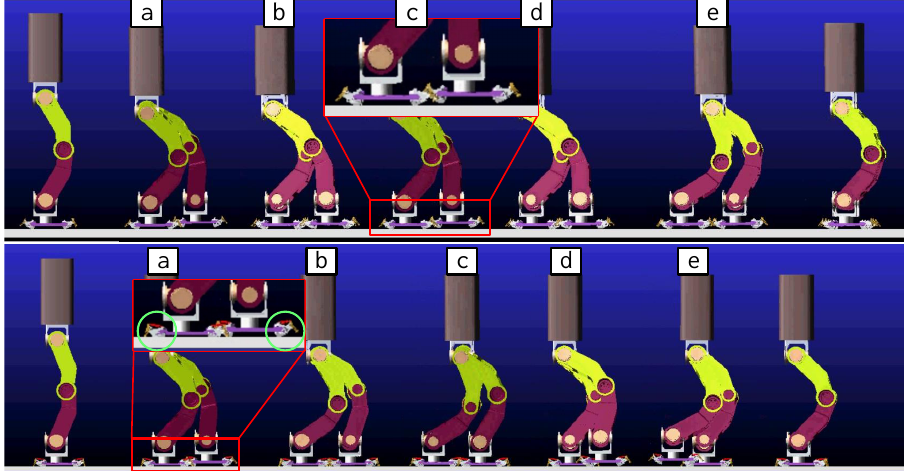
Figure 10. The dynamics simulation of a walking humanoid robot. The dynamics simulation of a walking humanoid robot. The red boxes indicate the partial enlargement of the foot. The green circles show the bionic mechanism in different states on different feet.